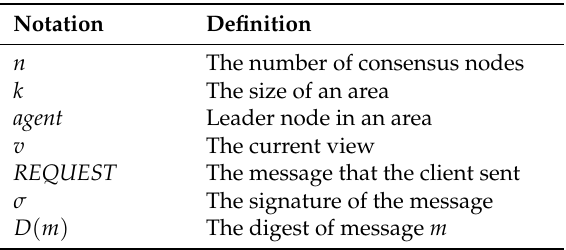
Table 2. Important notations.